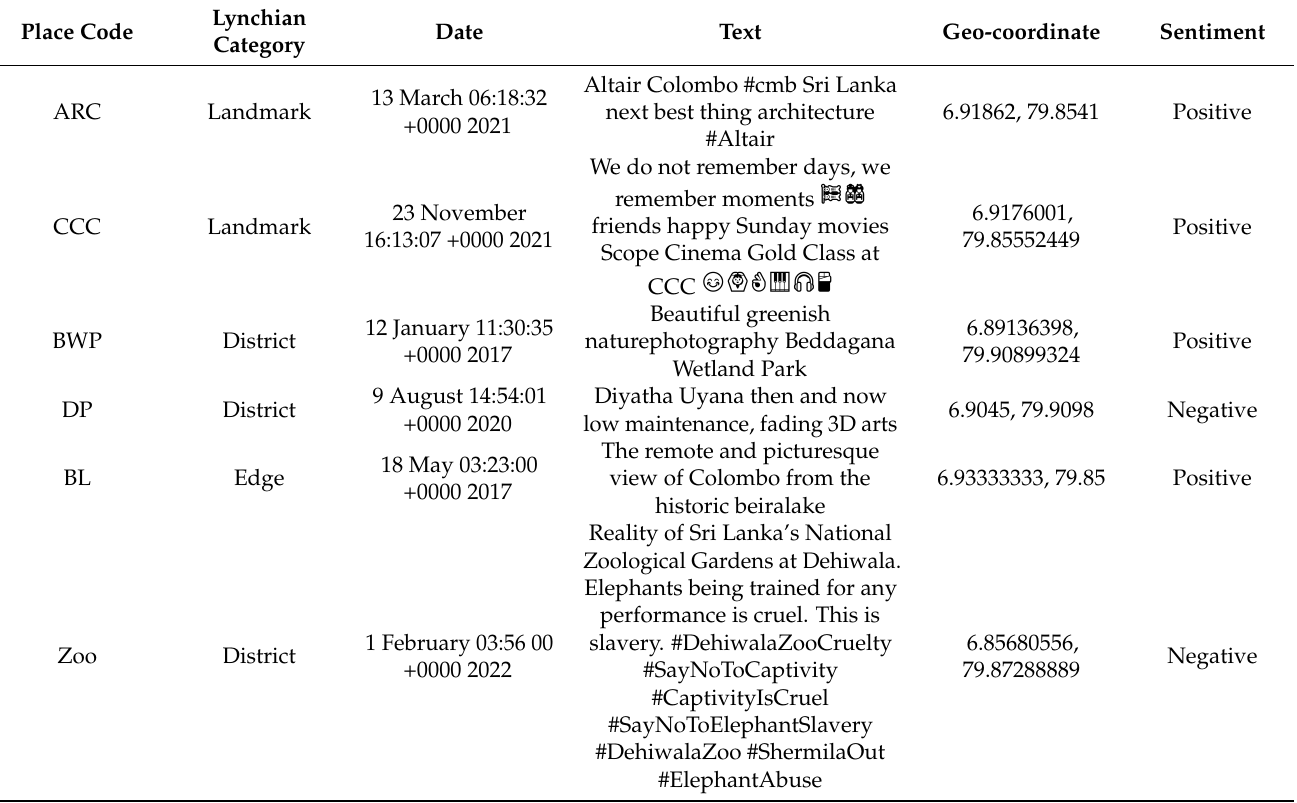
Figure 7. Color density matrix: Twitter popularity analysis. The frequency of the posts shared on Twitter and Instagram shows the community perceptions toward making memories with the places. According to Figure 7, GF, AIS, CF, KH, HH, LPB, PM, and BMICH can be considered the places which have received high attention on Twitter and Instagram. Table 3 shows the exemplary positively and nega- tively classified tweets, where Table 4 lists the frequently used word in the Twitter and Instagram posts shared per selected locations with increasing popularity. Table 3. Exemplary positively and negatively classified tweets.